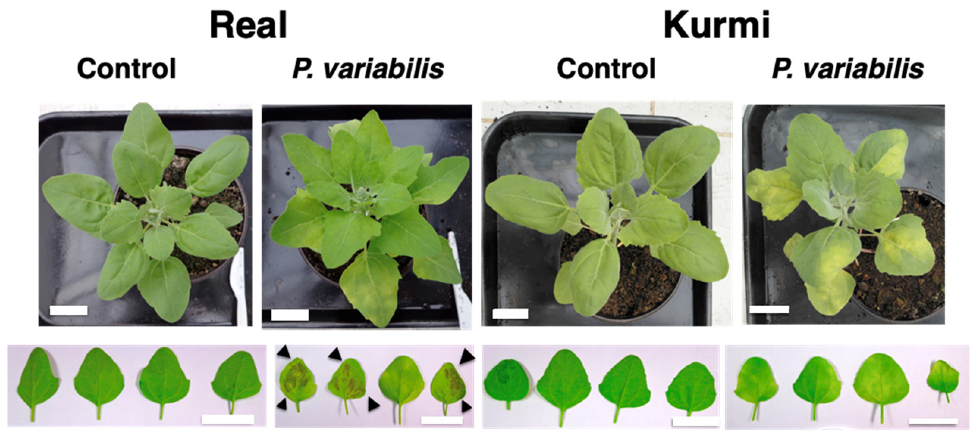
Figure 2. Quinoa plants infected with P. variabilis . The figure shows four-week-old quinoa plants 7 dpi with P. variabilis . Leaf yellowing is shown from the adaxial side (top) and Peronospora sporulation is shown from the abaxial side of freshly detached leaves from the second true leaf pair (bottom). The quinoa cultivar Real displays sporulation (black arrowheads) and the Kurmi cultivar only chlorosis. The images are representatives of at least three independent experiments with three to six biological replicates, all showing similar results. Each leaf in the lower panel was taken from a different biological replicate. The scale bars denote 4 cm.